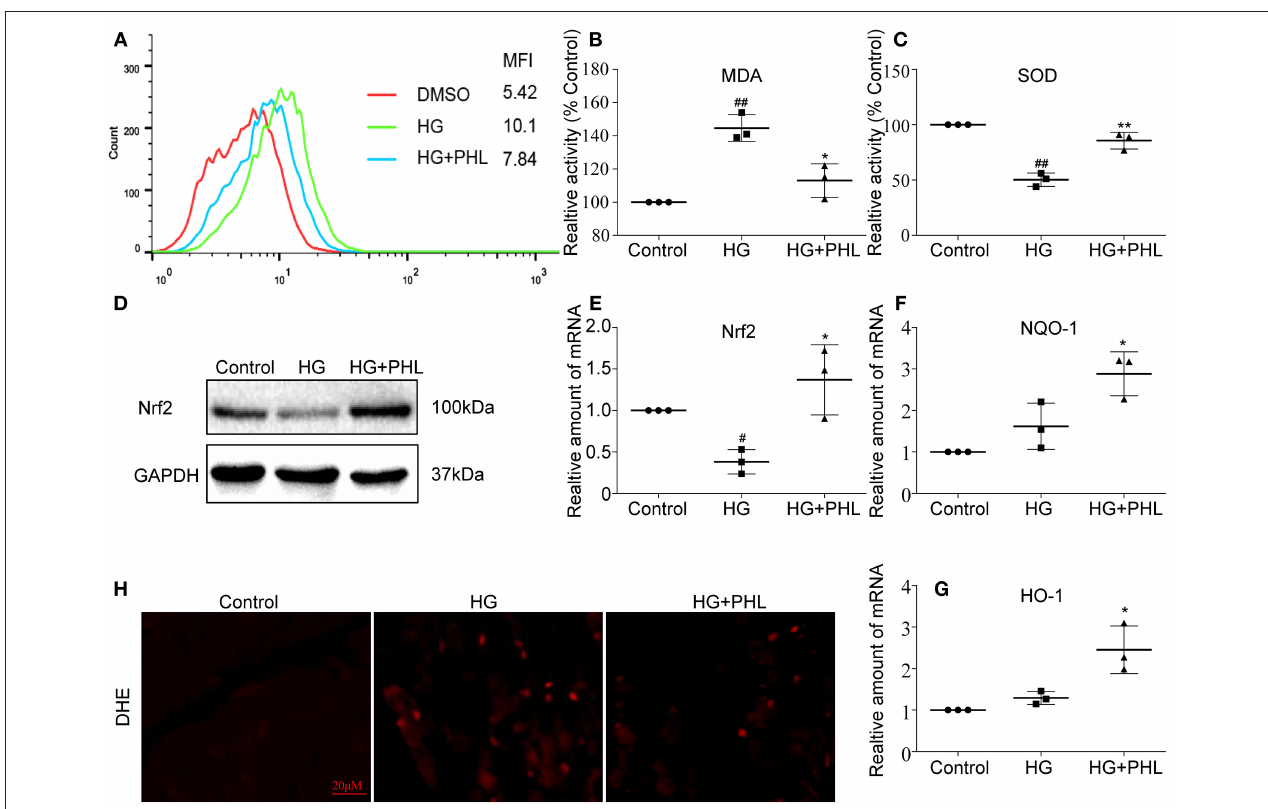
FIGURE 2 | PHL reduced hyperglycemia-induced ROS levels through induction of Nrf2 anti-oxidant responses in H9c2 cells. (A) PHL inhibited high glucose-induced ROS generation. H9c2 (1 * 10 6 ) cells pretreated with PHL (10 µ M) for 1h were incubated with HG (33mM) for 3h. DCFH-DA probes loaded and cells were processed by flow cytometry analysis for O 2 level, and mean fluorescence intensity (MFI) value was determined. (B,C) H9c2 (5 * 10 5 ) cells pretreated with PHL (10 µ M) for 1h and incubated with HG (33mM) for 6h. Levels of malondialdehyde (MDA) (B) in lysates prepared from H9c2 cells and enzymatic activity of superoxide dismutase (SOD) (C) as measured using colorimetric assays. (D) H9c2 (1 * 10 6 ) cells were pre-treated with PHL (10 µ M) for 1h and then incubated with HG (33mM) for 12h. The cell lysates were immunoblotted for Nrf2, with GAPDH as a loading control. (E–G) Total RNAs were extracted and the mRNA levels of Nrf2, HO-1, and NQO-1 were detected by RT-qPCR. Cells were treated as in (B) . (H) Staining of cultured H9c2 cells with DHE. DHE generates red fluorescence product (ethidium) in the presence of ROS. Cells were treated as in (A) . Data are presented as mean ± SEM. * P < 0.05, ** P < 0.01 vs. HG group; # P < 0.05, ## P < 0.01 vs. Control